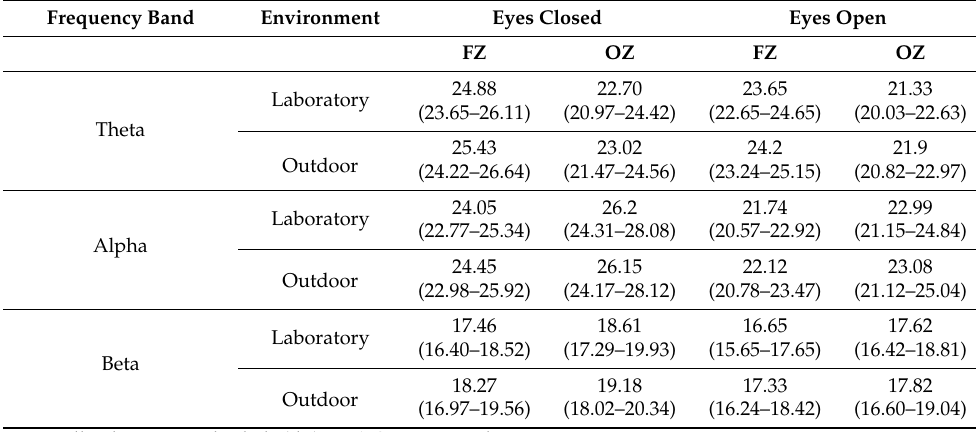
Table 2. Mean resting state EEG power.